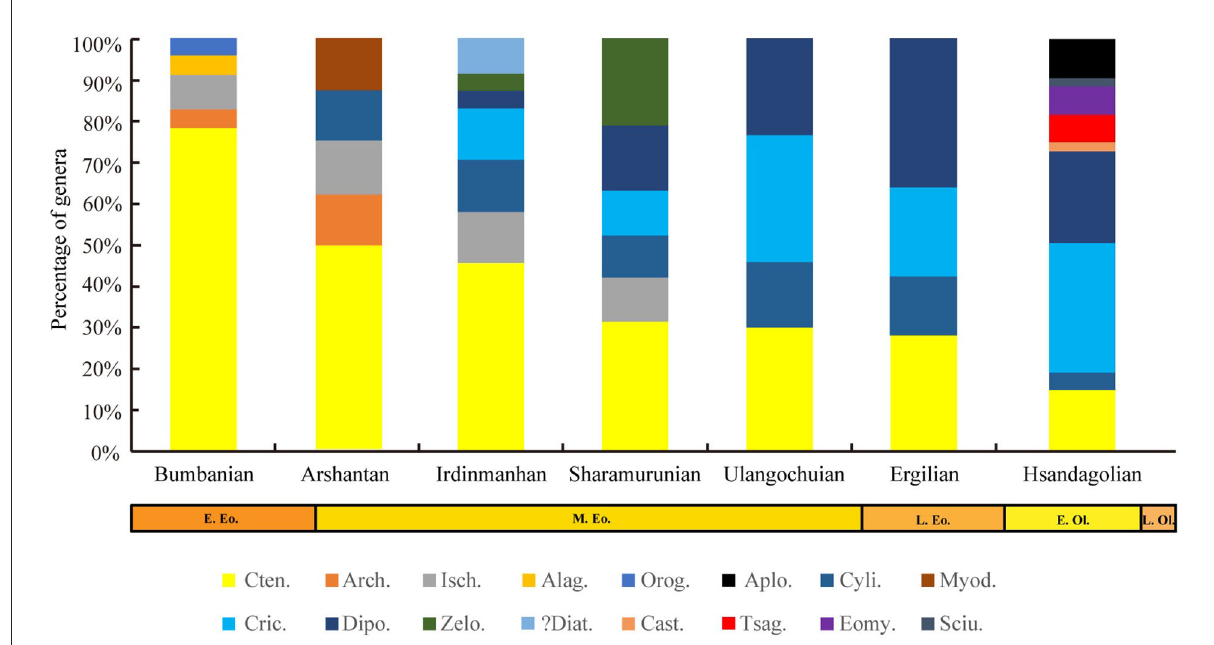
FIGURE8 East Asian rodent composition from the early Eocene to the early Oligocene. Aplo., Aplodontidae; Arch., Archetypomyidae; Alag., Alagomyidae; Cast., Castoridae; Cten., Ctenodactyloidea; Cric., Cricetidae; Cyli., Cylindrodontidae; Diat., Diatomyidae; Dipo., Dipodidae; Eomy., Eomyidae; Isch., Ischromyidae; Myod., Myodonta; Sciu., Sciuridae; Tsag., Tsaganomyidae; Orog., Orogomyidae; Zelo.,